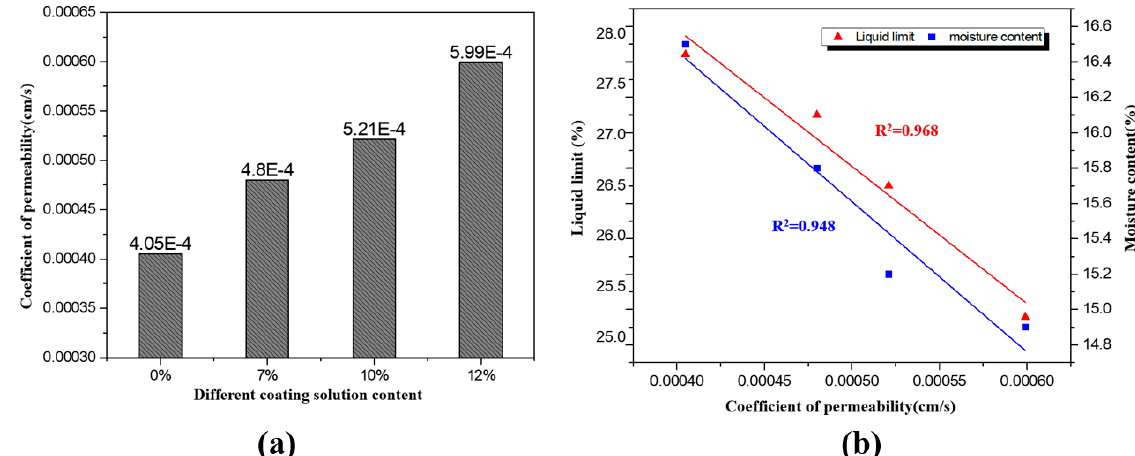
Figure 8. ( a ) Coefficient of permeability and ( b ) relationship between liquid limit, coefficient of permeability, and moisture content of soil samples.